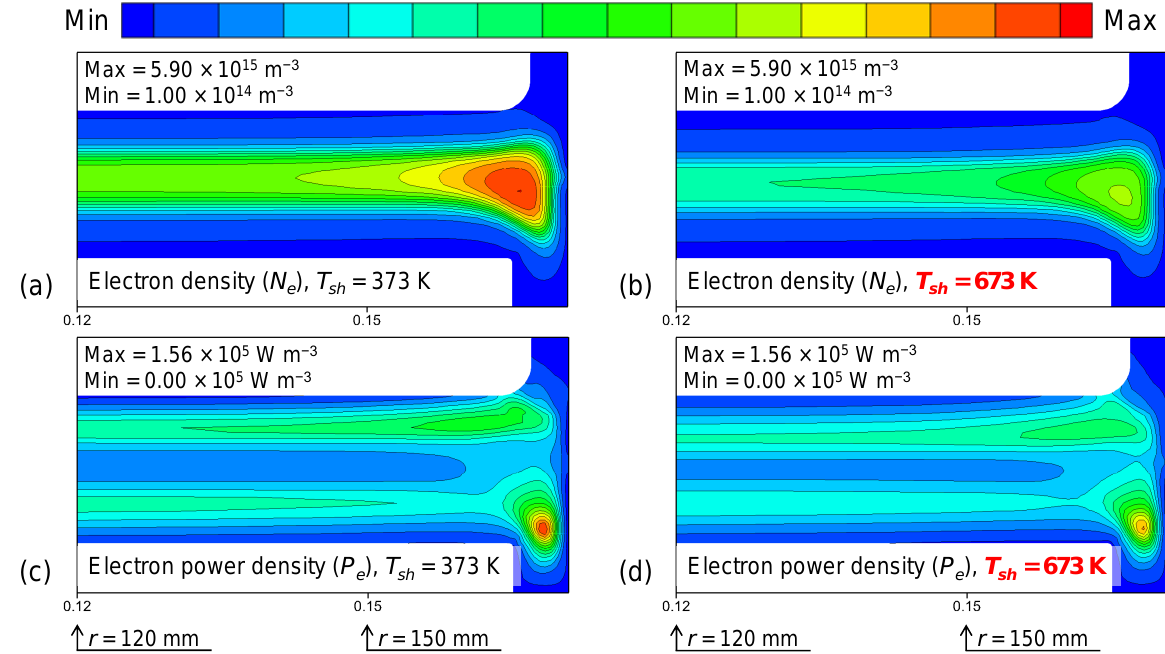
Figure 7. Effects of the showerhead temperature ( T sh ) on the spatial distribution of the plasma parameters. Contour plots for the spatial profiles of the time-averaged electron density ( N e , m − 3 ) for ( a ) Case 2 ( T sh = 373 K) and ( b ) Case 5 ( T sh = 673 K) for r ≥ 120 mm. Contour plots for the spatial profiles of the time-averaged electron power density ( P e , W m − 3 ) for ( c ) Case 2 ( T sh = 373 K) and ( d ) Case 5 ( T sh = 673 K) for r ≥ 120 mm. The profiles are radially uniform for r < 120